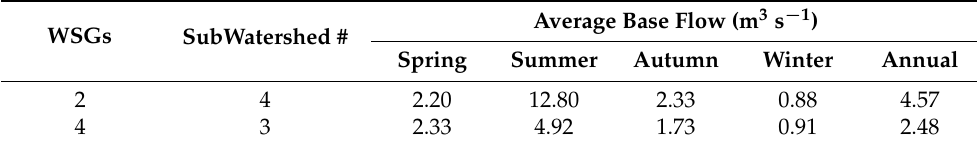
Table 9. Seasonal and annual average base flow in subwatershed #4 in WSG 2 and #3 in WSG 4.